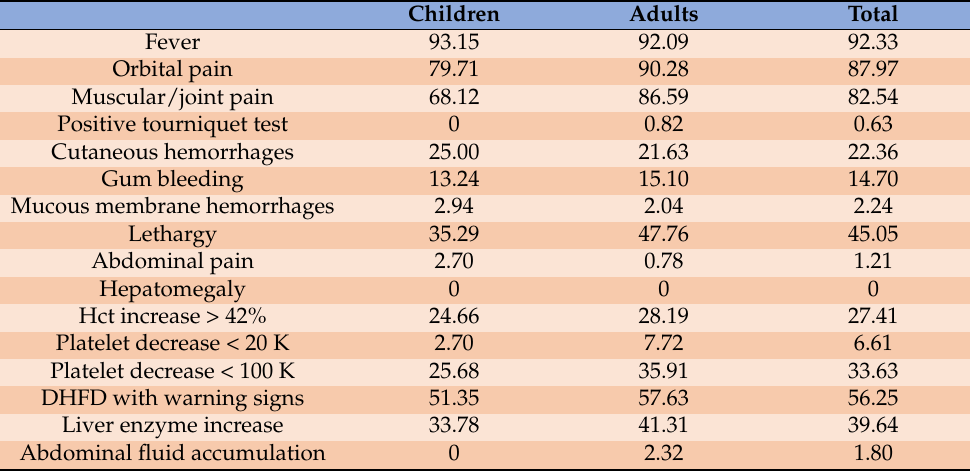
Table 3. Proportion of clinical manifestations in 336 patients diagnosed with